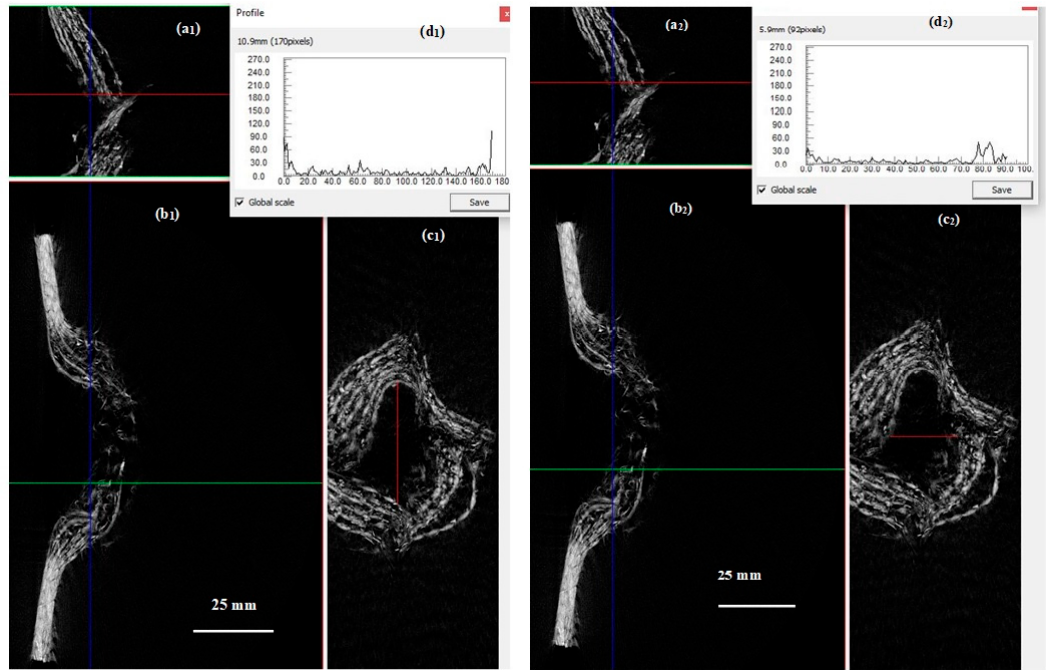
Figure 12. Slices and top view of the basalt fabric reinforced geopolymer composite after the impact test in longitudinal ( a1–c1 ) and transverse ( a2–c2 ) directions (the lines indicate where the other cross sections were taken). ( d1–d2 ) The response from the damaged area.